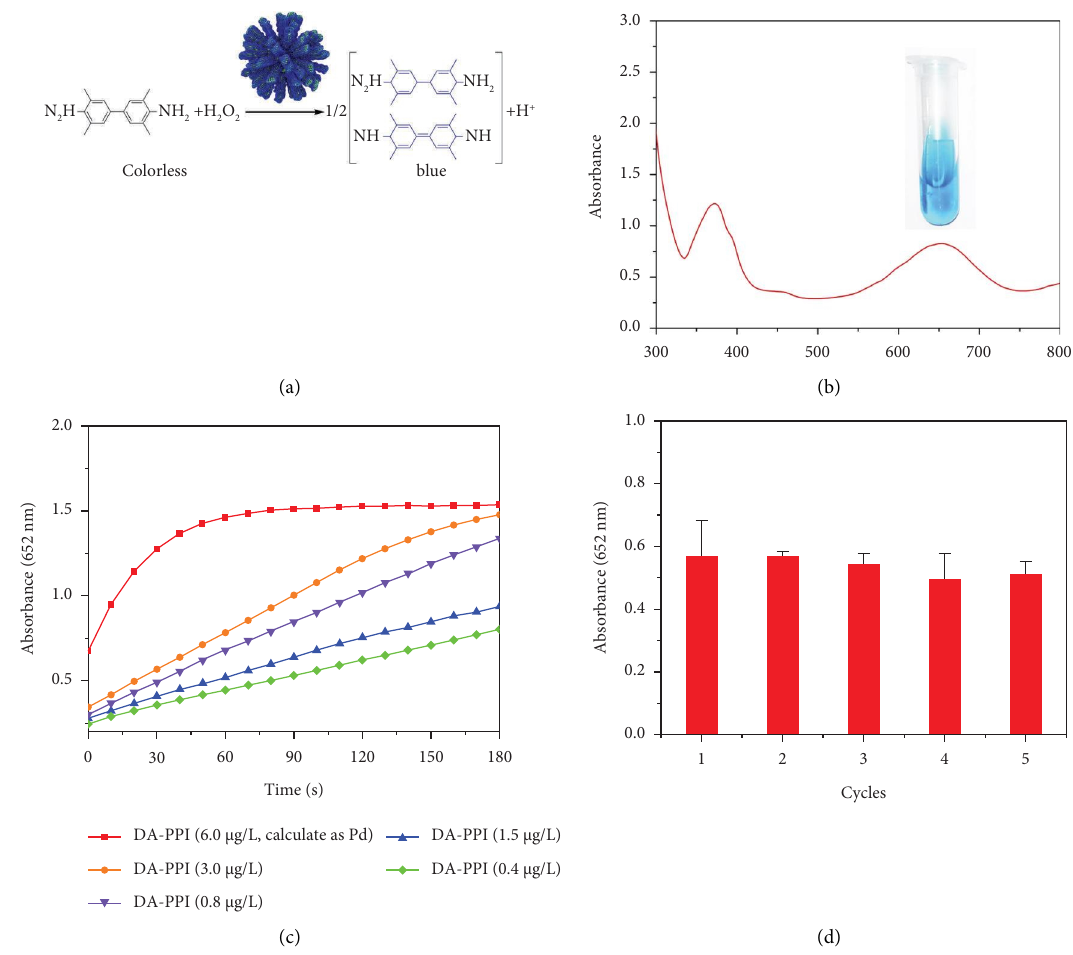
Figure 3: Te peroxidase-like activity of DA-PPI nanozyme (a). Te UV-vis spectrum of the TMB oxidative product (b). Te intensity (652 nm) ranged with the concentration variation of DA-PPI nanozyme (c). Te stability test for DA-PPI nanozyme in fve cycles (d). Table 1: Te enzyme kinetic parameters of D-PP nanozyme and DA-PPI nanozyme.